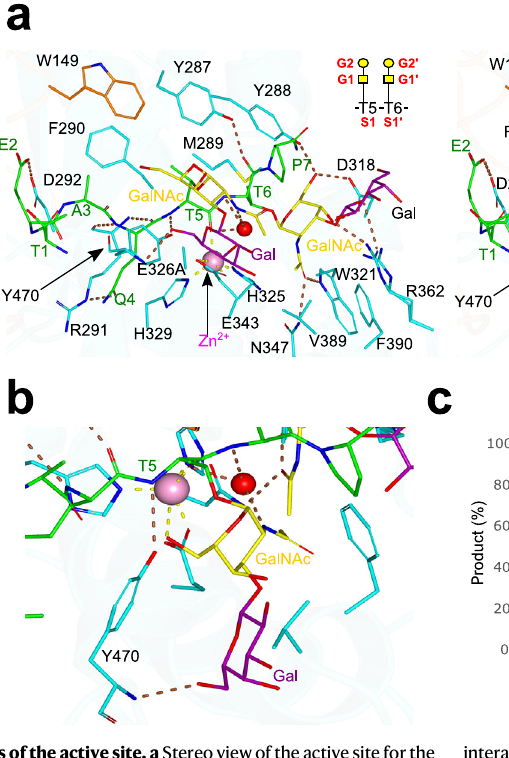
interactionsbetweenTyr470andtheGalNAcandGalmoietieslocatedatG1andG2, respectively. c Timecourseofacleavageassayusingthe0.4 μ MofwtAM0627 A21-E506 and the different mutants with P1 (57 μ M) incubated at 37°C. The cleavage was monitored by detecting the peak of substrate and product by MALDI spectra and the % of the remaining substrate and product formation was estimated. The raw spectra of MALDI-TOF analysis are given in Supplementary Fig. 3. All experiments were done induplicate ( n =2 independent experiments).Source data areprovided as a Source Data fi le. Note that each time point represents the average of two independent